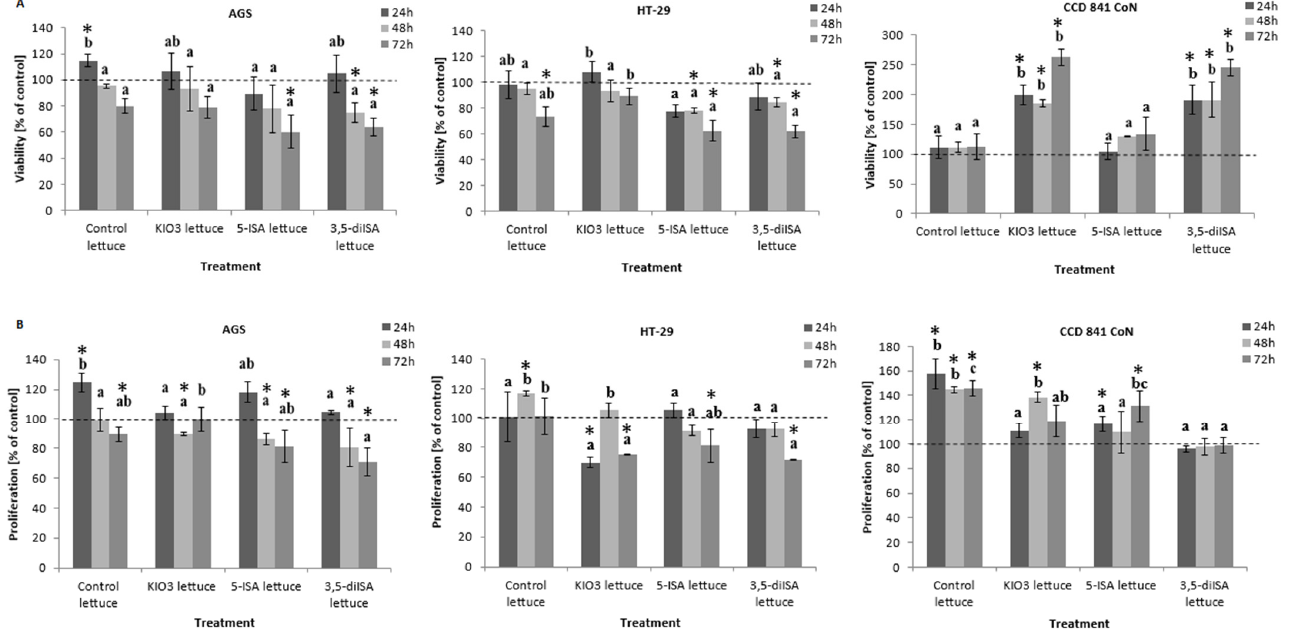
Figure 1. The effect of extracts from iodine-biofortified lettuce on cell viability ( A ) and proliferation ( B ) in human gastrointestinal cell line AGS, colorectal adenocarcinoma cell line HT-29 and normal colon epithelial cell line CCD 841 CoN. Cells were treated for 24, 48 and 72 h with 1000 µg/mL extracts from control lettuce, or KIO3- fortified lettuce, or 5-ISA-fortified lettuce, or 3,5-diISA-fortified lettuce. Statistical significance was assessed using one-way ANOVA followed by Tukey’s post hoc. Columns with the same letter are not significantly different ( p > 0.05). * differences statistically significant relative to the negative control sample (NC) when p < 0.05 ( t -test).